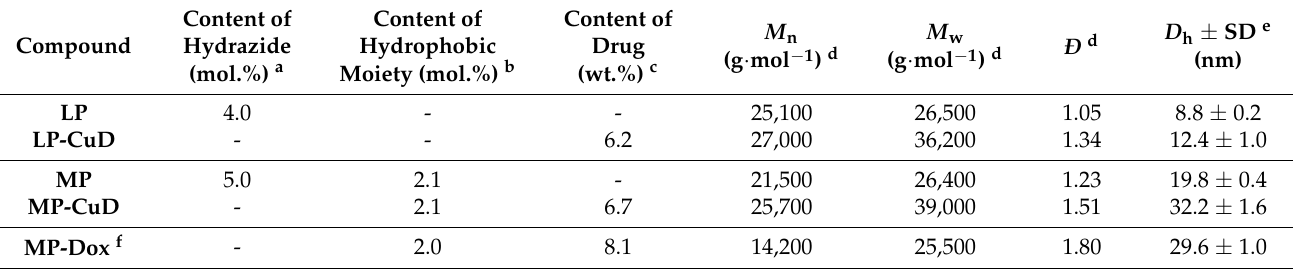
Table 1. Physicochemical characteristics of hydrophilic or amphiphilic copolymer precursors (LP or MP, respectively) and their conjugates with CuD (LP-CuD and MP-CuD) or Dox